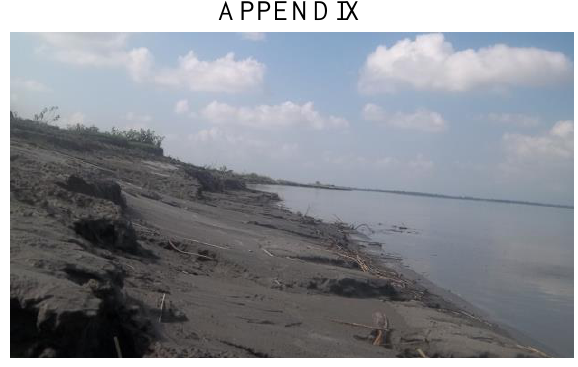
Figure 7. Unvegetated bar erosion at Char Maina Jamuna River, Jamalpur.